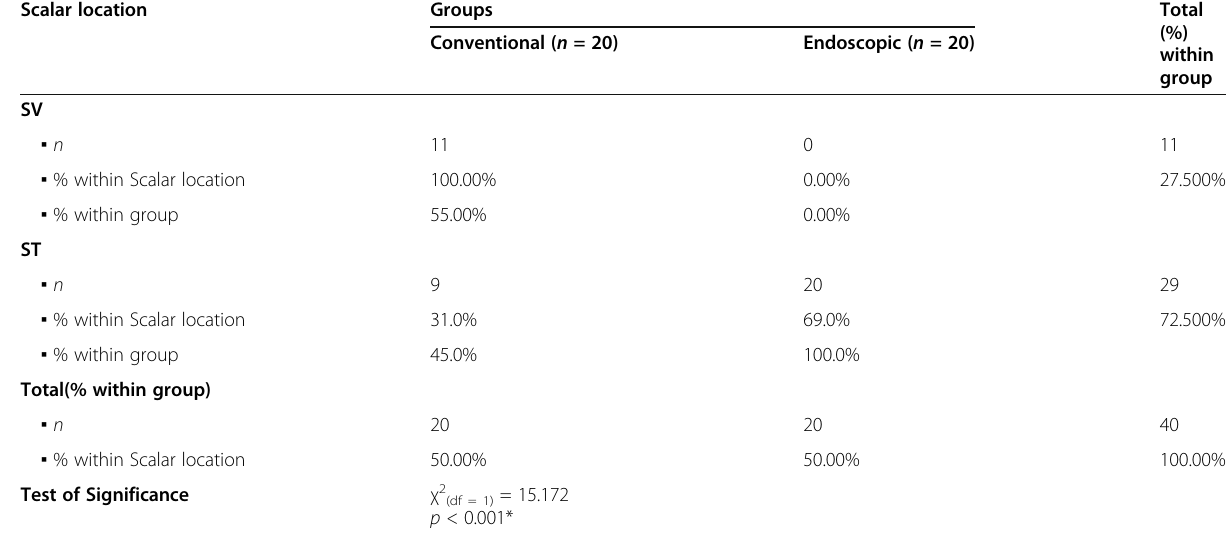
Table 2 A comparison between the scalar location in both the posterior tympanotomy and the EAEA groups; 69% of the ST location was via the EAEA which represented 100% of the endoscopic cases in comparison to only 31% via the conventional approach which was only 45% of the conventional cases, a difference that was found statistically significant ( p < 0.001*)